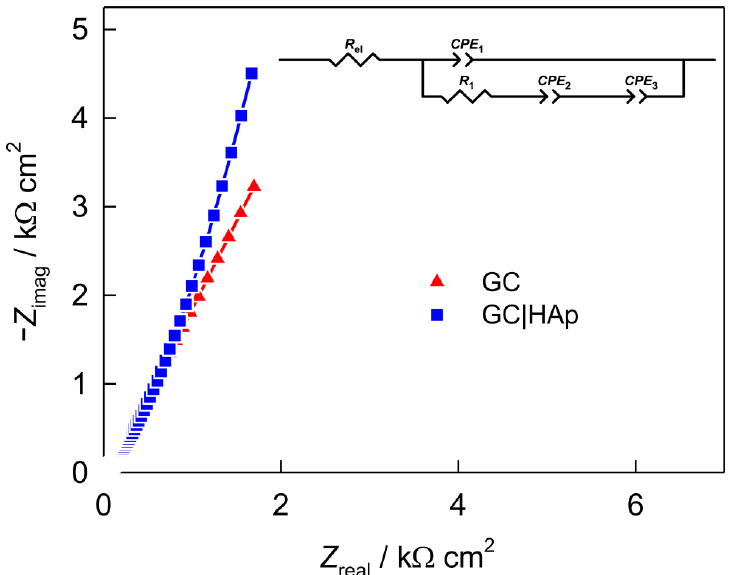
Figure 4. Nyquist plot of the unmodified and modified GC electrodes recorded at E OCP in 0.2 M KNO 3 (pH = 4) solution. Inset: The EEC used to fit the EIS data ( E OCP for bare the GC electrode = 0.0505 V and for the HAp/GC electrode = 0.0727